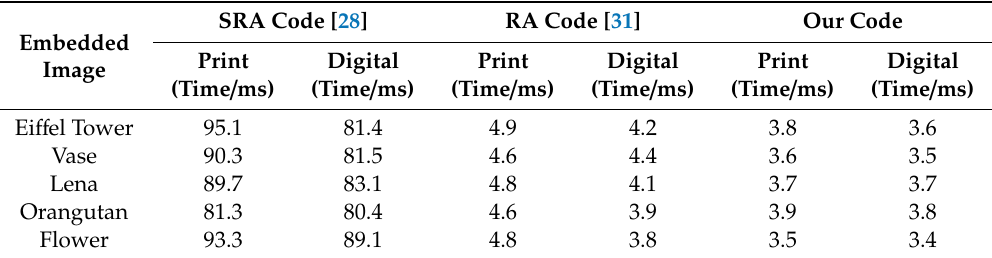
Table 1. Decoding robustness comparisons in terms of decoding time. The size of the printed picture was 4 × 4 cm 2 and the threshold value was 20.